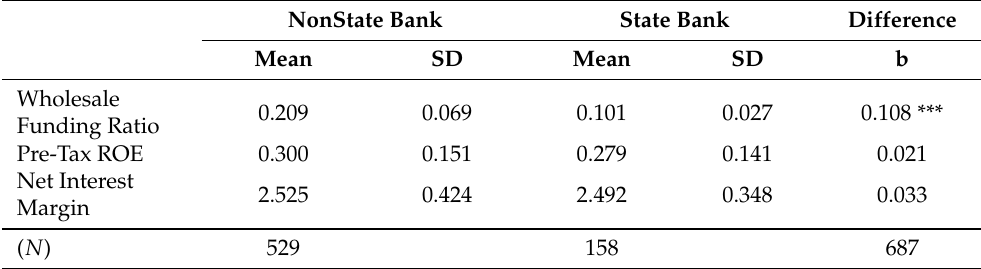
Table 1. Summary